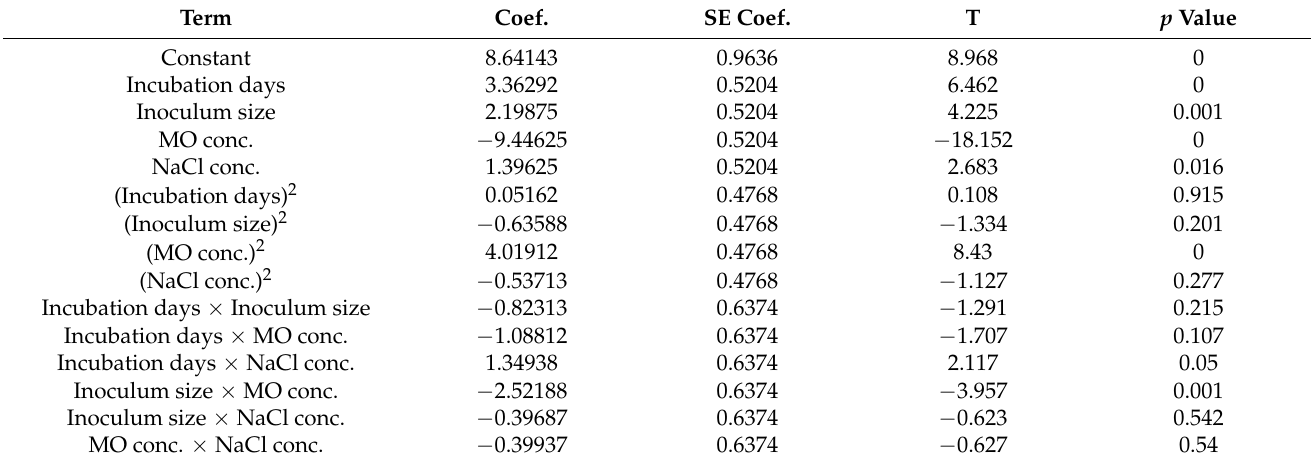
Table 3. Estimated effect, regression coefficients and corresponding T and p values for determining the effects of different variables on MO degradation by means of immobilized consortium using CCD.